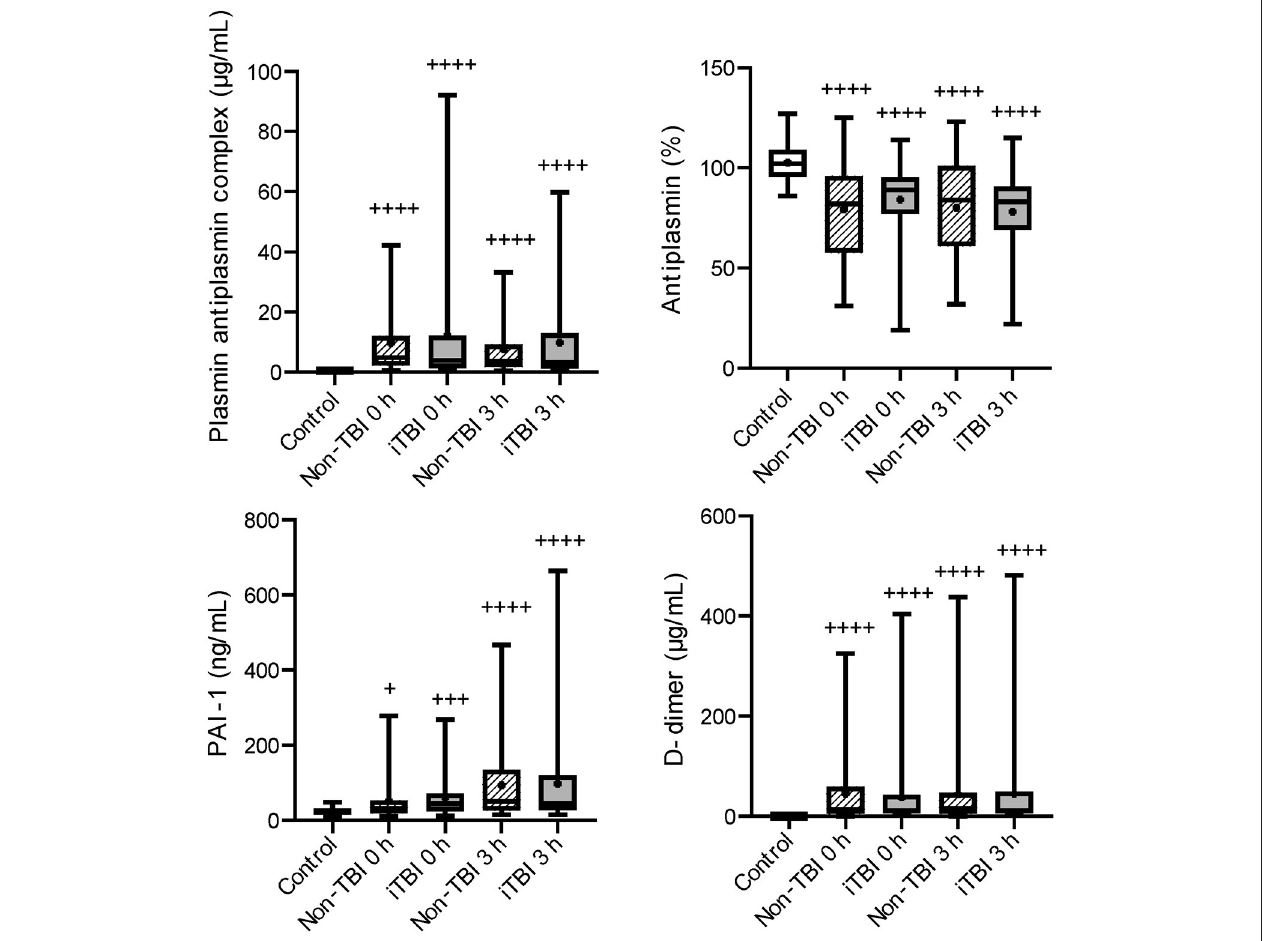
FIGURE 2 | Serial changes in the fibrinolysis-related molecular markers. Healthy controls (white box), non-traumatic brain injury (TBI) (hatched boxes), and isolated TBI (iTBI) (gray boxes) at presentation to the emergency department (0h) and 3h after hospital arrival (3h). Horizontal bars in the box indicate the median (middle) and interquartile ranges (upper 25% and lower 75%). Black boxes are mean values. + p < 0.05 vs. healthy controls, + + + p < 0.001 vs. healthy controls, + + ++ p < 0.0001 vs. healthy controls. None of the markers significantly differed between the iTBI and non-TBI groups.